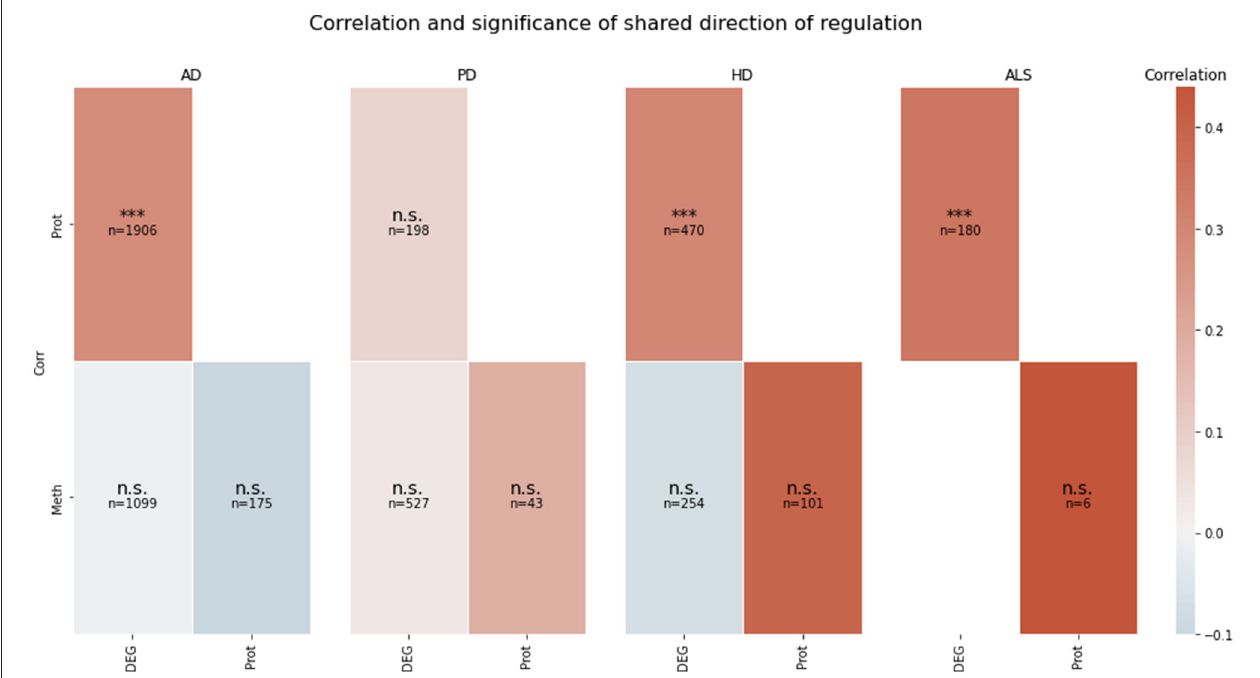
FIGURE 2 | Pairwise correlation of the omics-layers per disease. For each of the four NDDs, a heatmap is showing the pairwise correlation value of the mean direction of regulation between each pair of omics-layers, which shows a direction of regulation (transcriptomics, proteomics, methylomics). Additionally, the significance of the correlation is given in each tile (n.s., not significant, ***p < 0.001). SNP, genomic level; DEG, transcriptomic level; Prot, proteomic level; Meth, methylomic